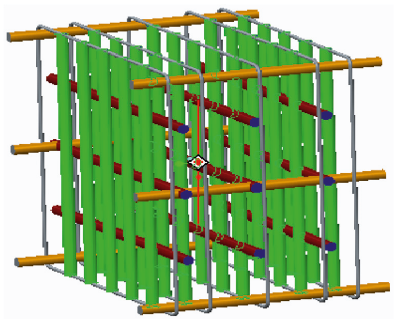
Figure 4: Internal structure of the concrete vault.